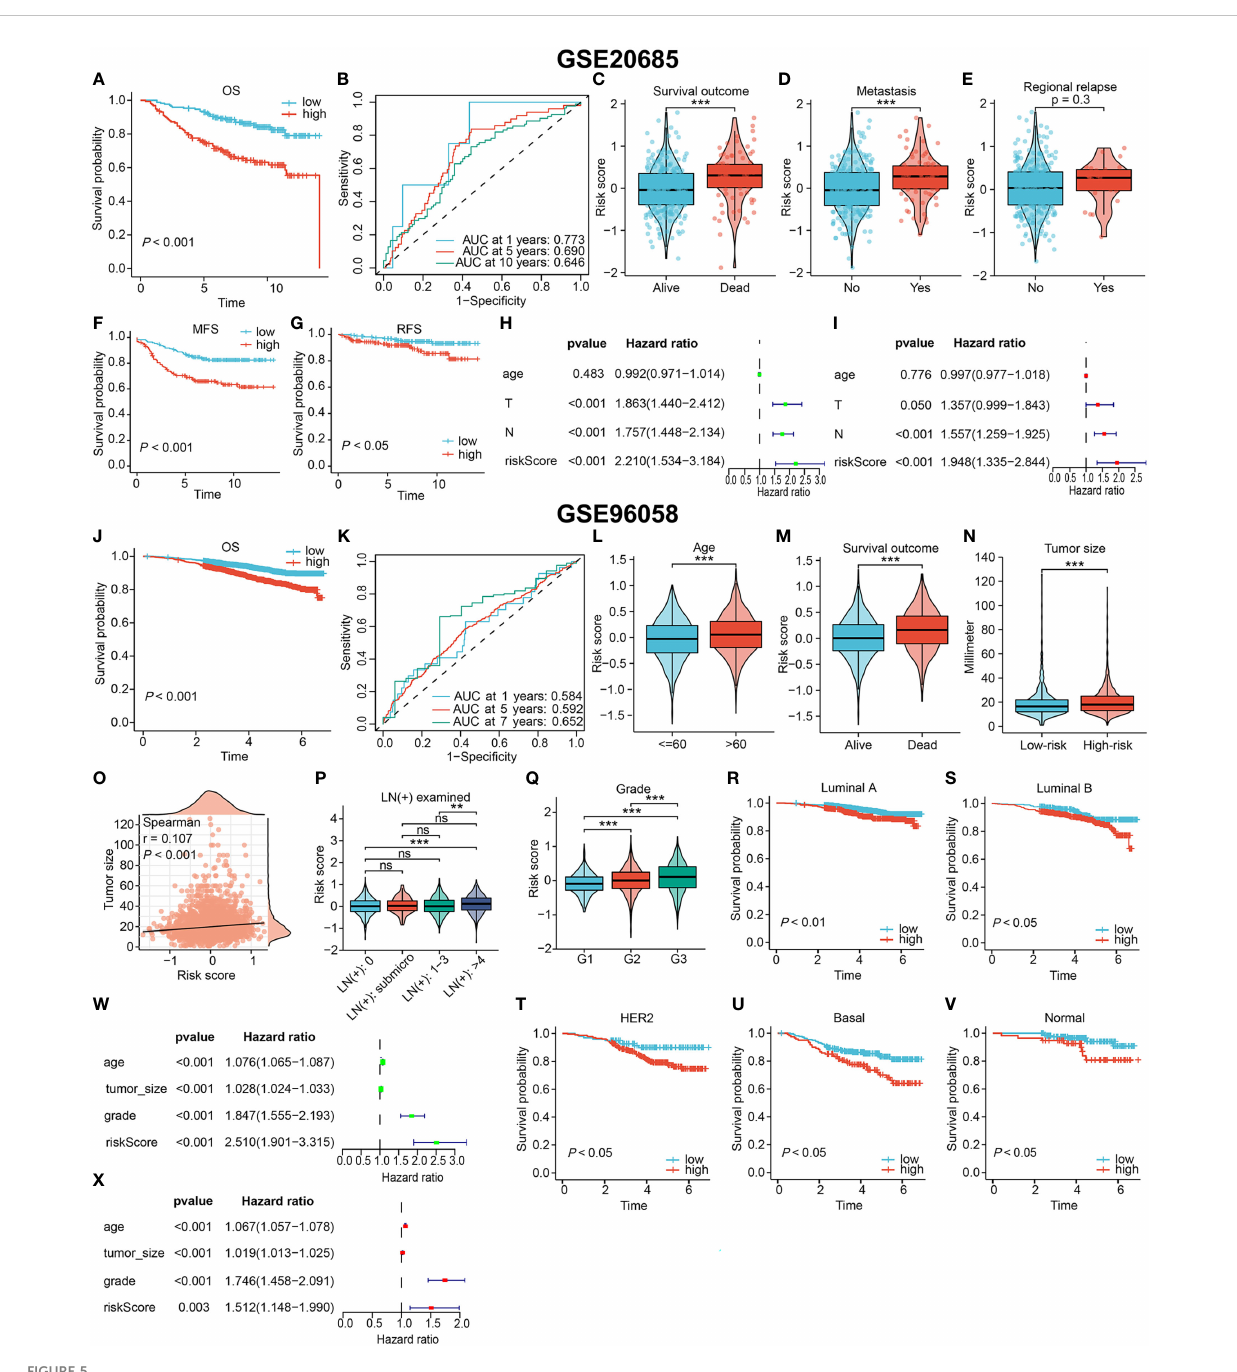
FIGURE 5 Validating the prognostic value in two independent external cohorts. (A – I) Results based on GSE20685 cohort. The OS curve (A) , MFS curve (F) , RFS curve (G) of patients. (B) The ROC curve to evaluate the predictive accuracy. The association of the signature with the survival outcome (C) , metastasis event (D) and relapse event (E) . Con fi rming the signature independence via univariate (H) and multivariate (I) Cox analyses. (J – X) Results based on GSE20685 cohort. (J) The OS curve of all patients. (K) The ROC curve to evaluate the predictive accuracy. The association of the signature with the age (L) , survival outcome (M) , tumor size (N, O) , lymph node involvement (P) and histological grade (Q) . (R – V) Overall survival curves of patients with different PAM50 types. Con fi rming the independent prognostic role via univariate (W) and multivariate (X) Cox analyses. (ns, not signi fi cant, **P < 0.01, ***P <